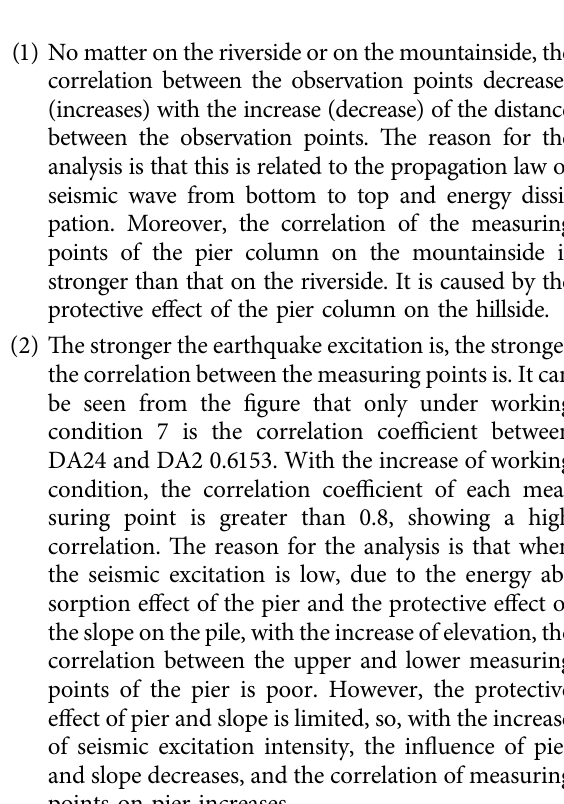
Figure 13: Correlation coefficient diagram of bridge pile mea- suring points under different working